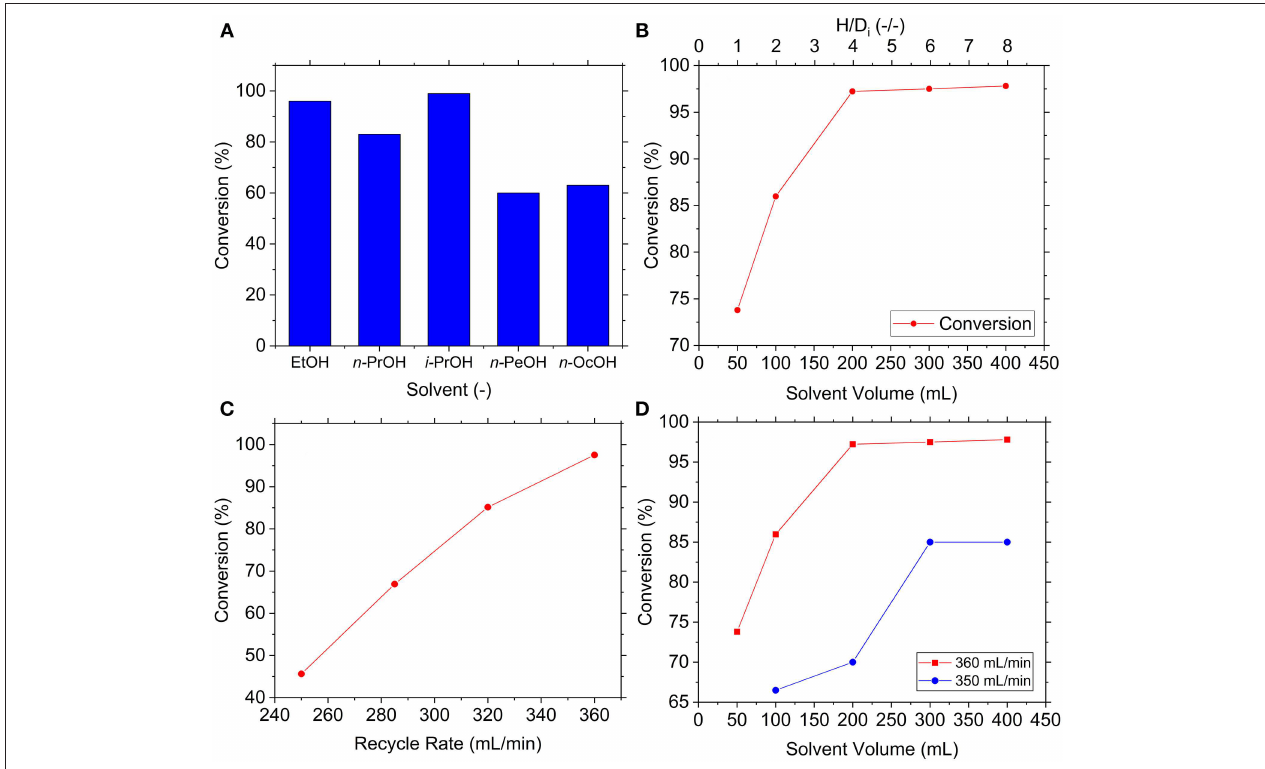
FIGURE 4 | Effect of various reaction conditions on synthesis of ammonium carbamate namely (A) solvent, (B) solvent volume, (C) recycle rate, and (D) solvent volume at reduced recycle